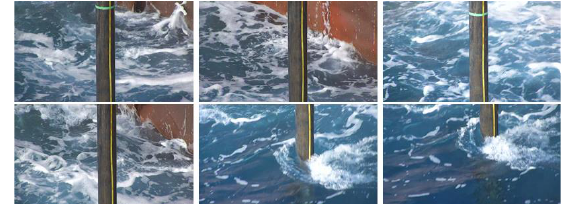
Figure 2. Movement of the sea region compared to the riser. This kind of situation impair